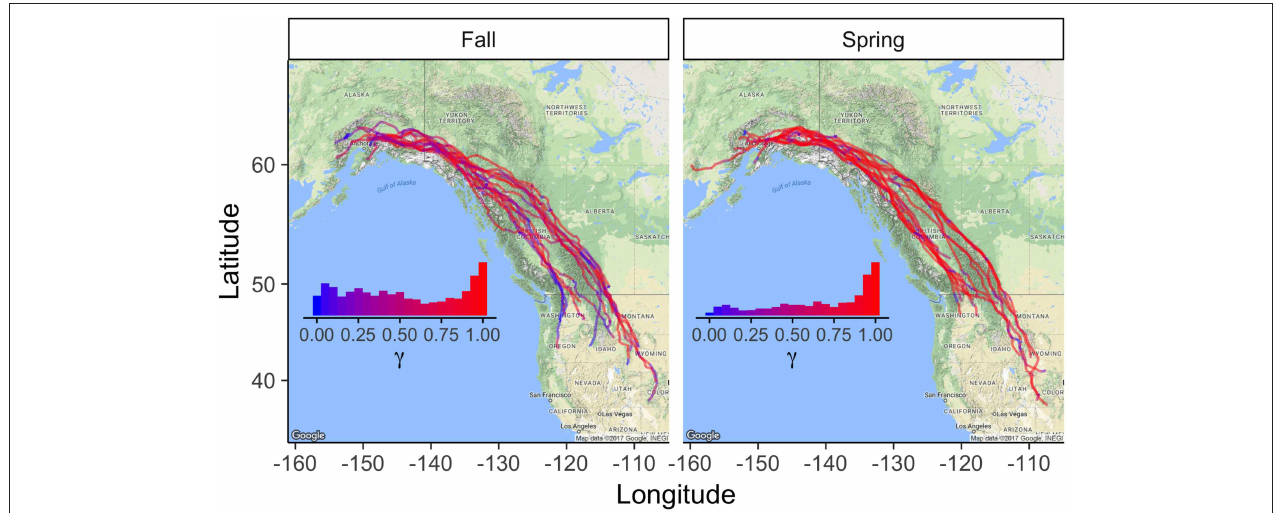
FIGURE 3 | Golden eagle migration trajectories ( N = 15 spring and N = 16 fall). Hue indicates value of behavioral parameter γ estimated with the correlated random walk model with full behavioral process, including orographic uplift, thermal uplift, and wind support as predictors. Insets show the relative frequencies of estimates of γ assigned to the displacements between observed daytime GPS locations. γ close to one reflect movements associated with migratory behavior, and γ close to zero stopover behavior. Daily rhythms, revealed in Figures 1 , 2 , are not apparent here because the birds moved so little at night.